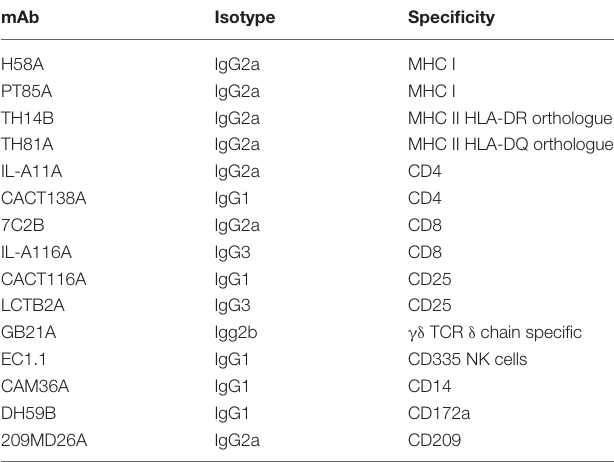
TABLE 1 | mAbs used to study the immune response to mycobacterial pathogens. mAb Isotype Specificity